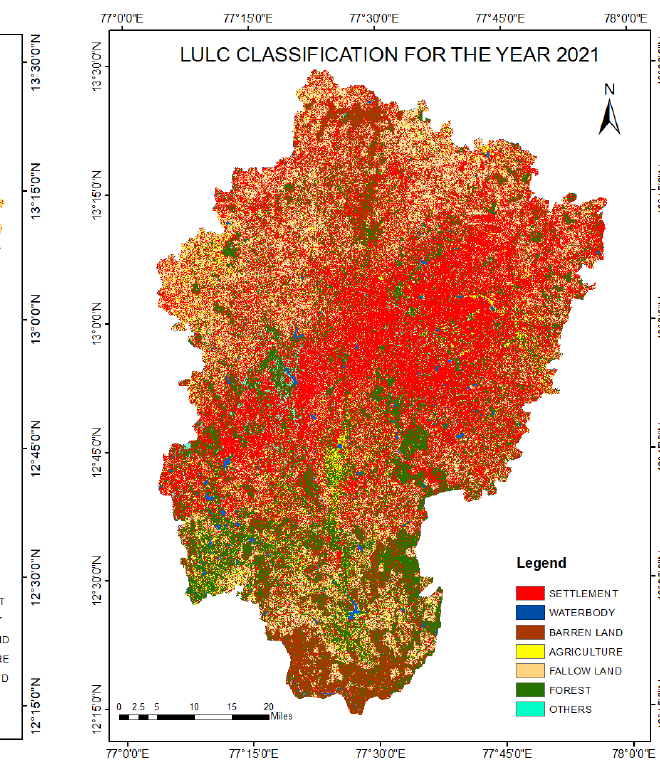
Figure 4: LULC Classes of 2001